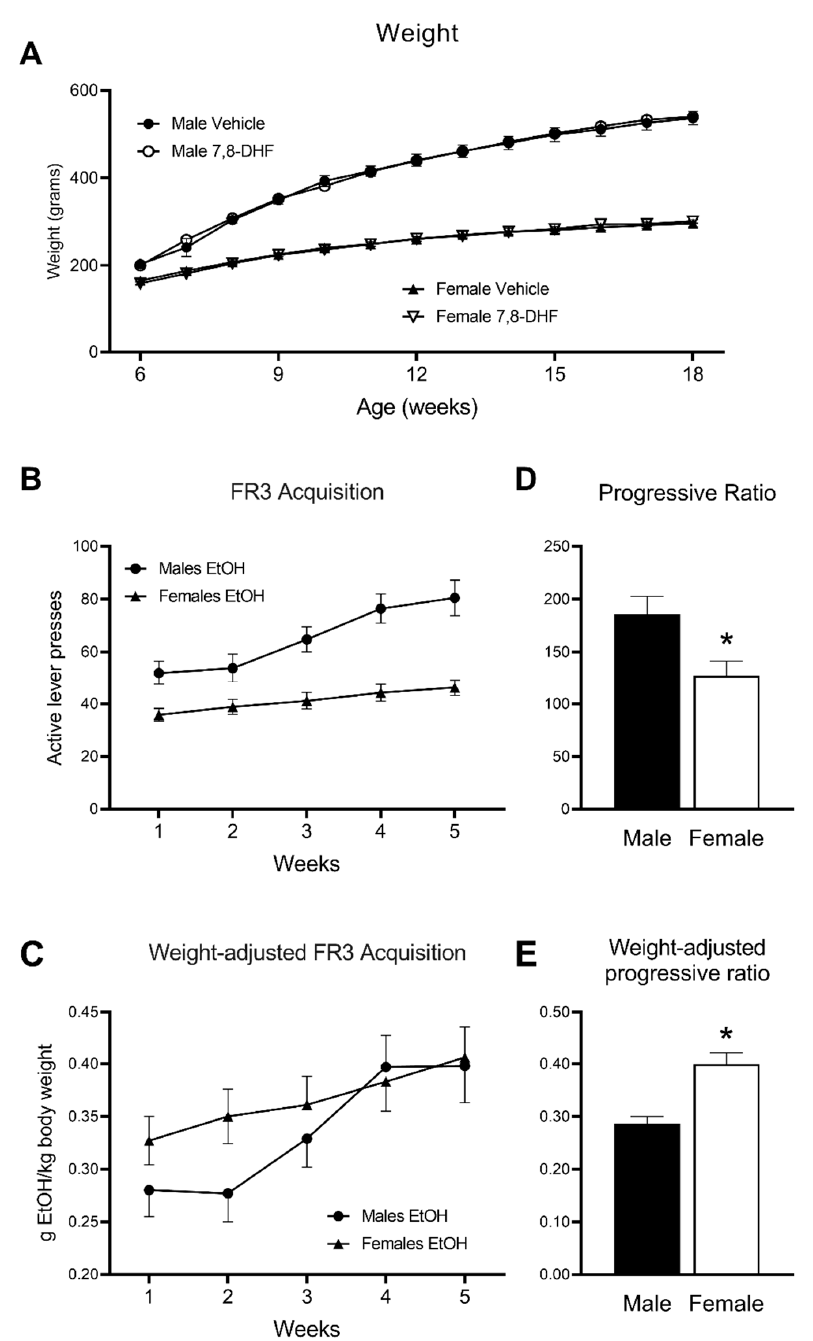
Figure 2. ( A ) Average weight of male and female SD rats across the duration of operant ethanol self-administration. Male rats were significantly heavier than female rats at all time points, but no significant differences were detected between vehicle and 7,8-DHF treatment groups. ( B ) Operant responding at FR3 to a 10% v / v ethanol solution in SD rats. Acquisition rate was similar across sexes although males had significantly higher numbers of active lever presses. ( C ) Weight-adjusted amount of ethanol ingested at FR3. Acquisition rate was faster in males than in females, but at 5 weeks there were no significant sex differences. ( D ) Breakpoint number of active lever pressing for a 10% v / v ethanol solution was significantly higher in male compared to female rats. ( E ) Weight-adjusted breakpoint amount of ethanol ingested per body weight was significantly higher in female rats than in males. In all cases, data are mean ± SEM. The number of animals was n = 12 in each group in 2A and n = 24 in each group elsewhere. * = p < 0.05 for difference between males and females.